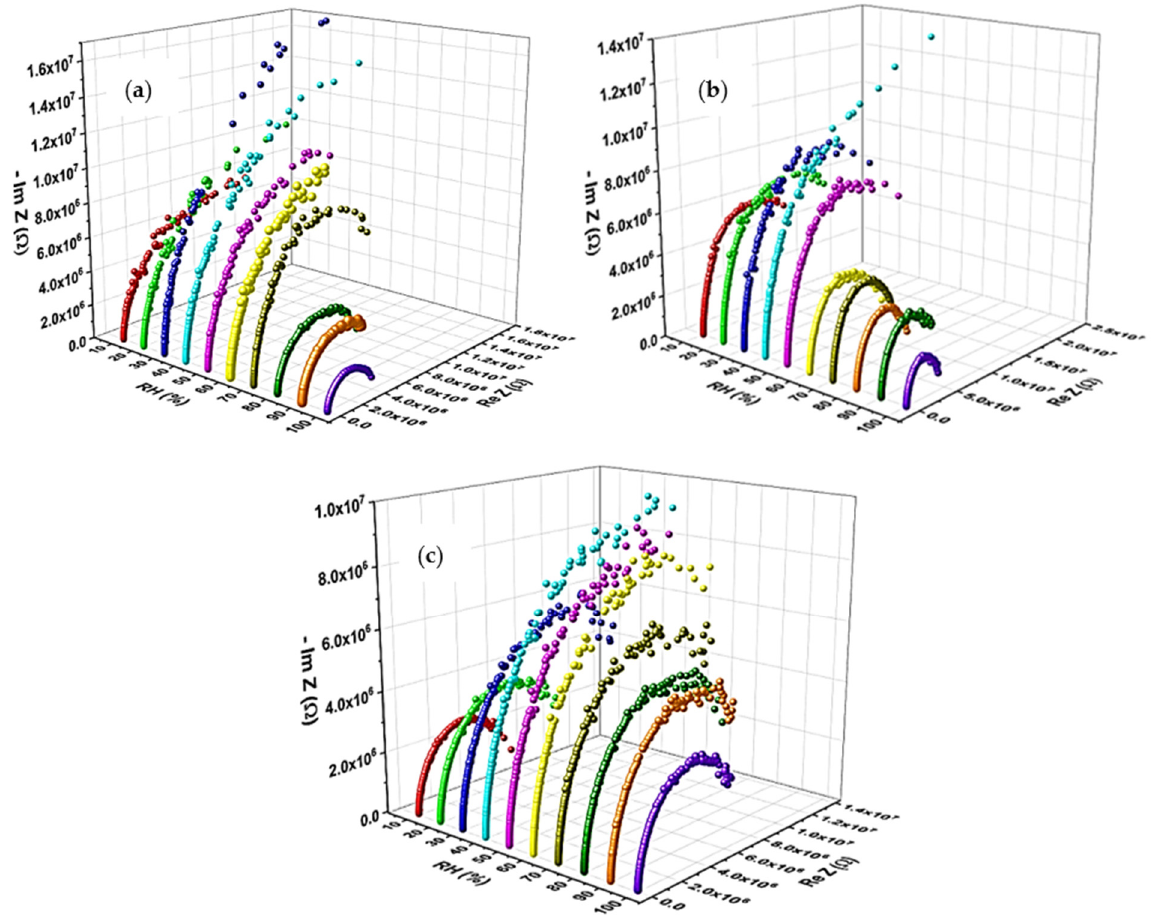
Figure 7. Nyquist Plot of TW-Nb MMO as a function of RH, in the frequency range from 400 Hz to 40 MHz, for the ( a ) TW − Nb 2, ( b ) TW − Nb 4 and ( c ) TW − Nb 6 samples.